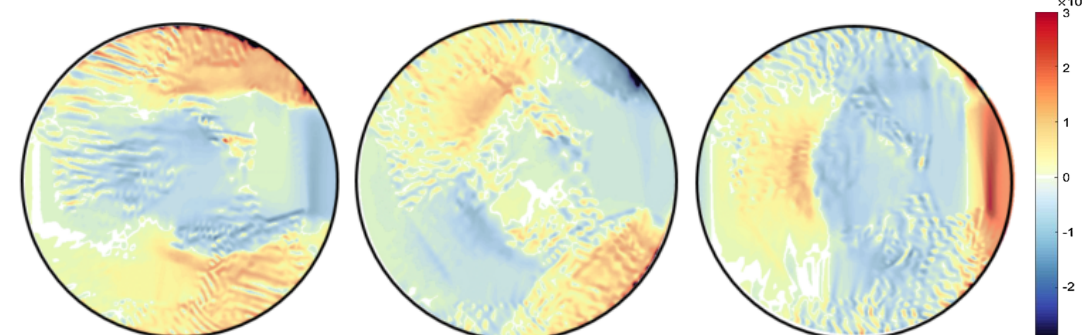
Figure 7. Ring-and-plug reconstructed strain field ε xx , ε xy , ε yy for mesh type MT1.